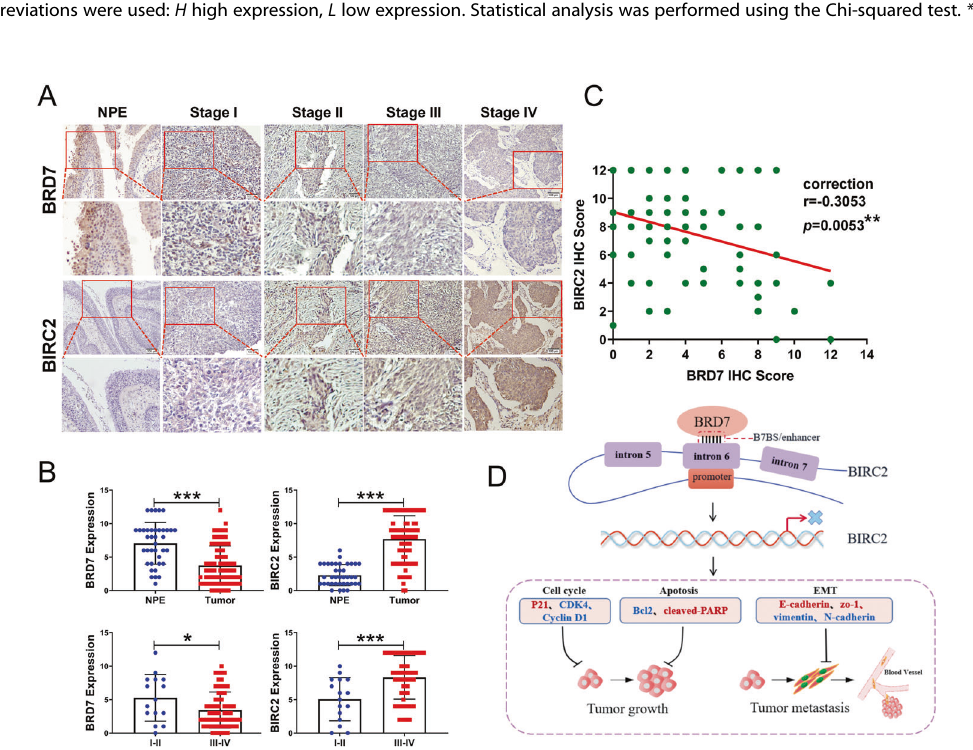
Fig. 8 BRD7 expression was negatively correlated with BIRC2 in clinical NP and NPC tissues. A Representative image of BRD7 and BIRC2 expression in noncancerous nasopharyngeal tissues and different clinical TNM stages of NPC detected by IHC. B Statistical diagram of BRD7 and BIRC2 expression in noncancerous nasopharyngeal tissues and different clinical TNM stages of NPC. C Correlation between BRD7 expression and BIRC2 expression. D A schematic map showing the tumor-suppressive mechanism of BRD7 that occurs by repressing the enhancer activity and expression of BIRC2 in NPC. Red represents upregulated genes, and blue represents downregulated genes. Error bars represent the mean ± SD. *P < 0.05, **P < 0.01, ***P <